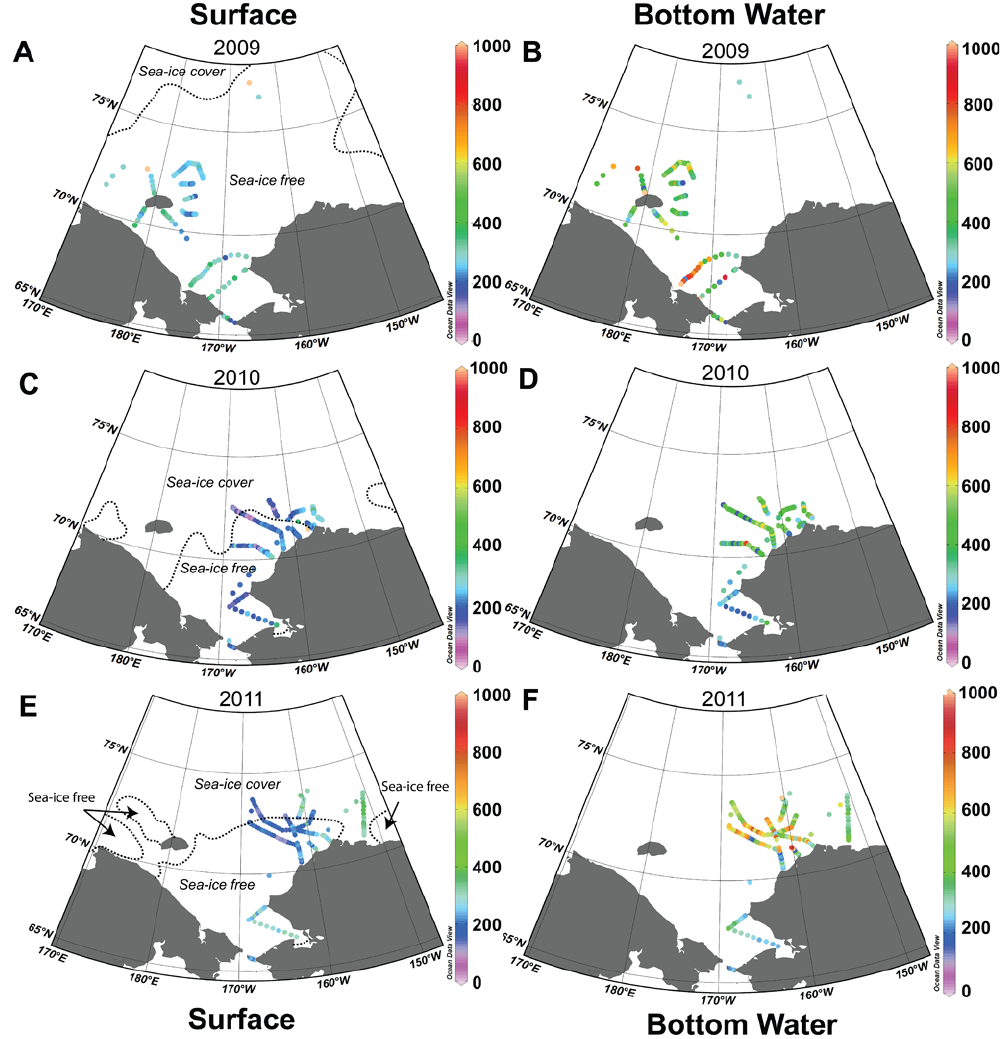
Fig. 4. Summertime surface and bottom-water maps of seawater p CO 2 (µatm) for individual years in 2009, 2010 and 2011 in the western Arctic Ocean (primarily Chukchi Sea but also eastern East Siberian Sea and western Beaufort Sea). Surface seawater p CO 2 data are plotted in (A) , (C) and (E) , while bottom-water seawater p CO 2 data are plotted in panels (B) , (D) and (F) . Sea ice data were retrieved from the National Snow and Ice Data Center (Cavalieri et al., 1996, updated yearly;